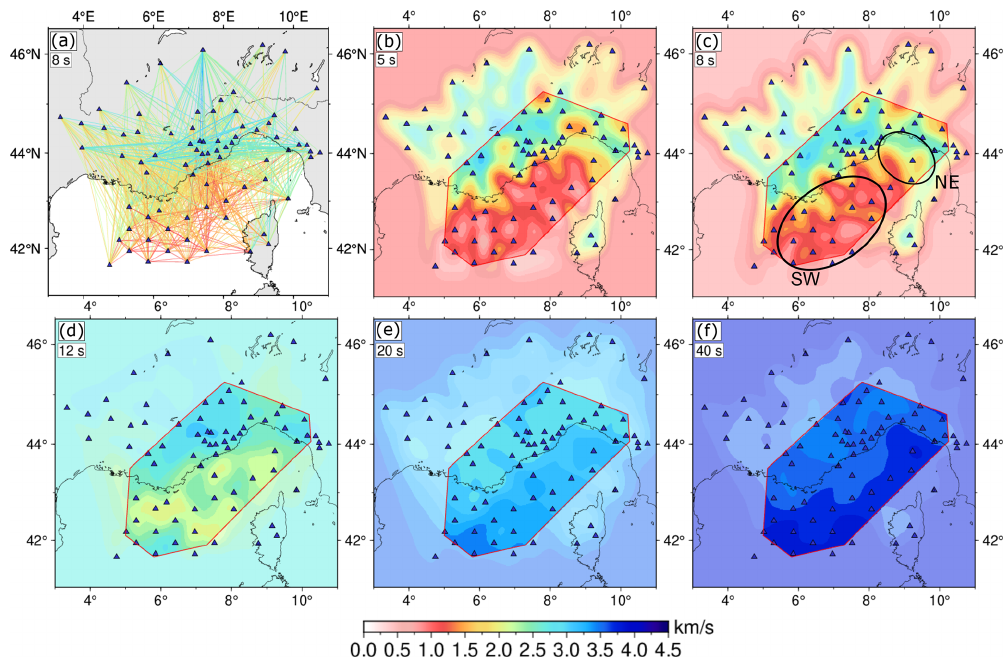
Figure 6. Panel (a) shows the tomography input for 8s as a ray path plot. Panels (b) – (f) show group velocity maps of the Ligurian Basin from surface wave tomography for periods of 5, 8, 12, 20, and 40s, whereby (b) , (c) , and (d) are based on ambient noise cross-correlation and (e) and (f) are based on the cross-correlation of teleseismic events. A red polygon marks the resolved area. Areas of low resolution are shown in transparent colours; areas without ray coverage show the initial velocity. Annotations in (c) mark the south-western and central (SW) and the north-eastern (NE) Ligurian Basin. Blue triangles represent stations.